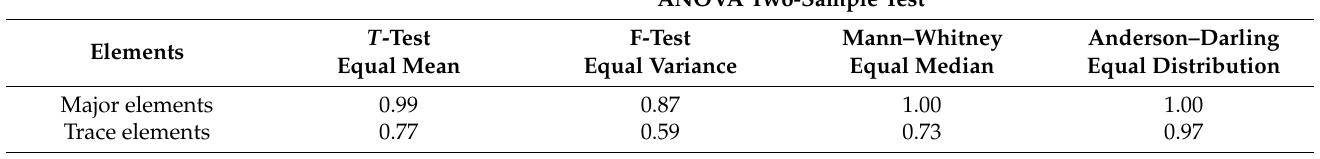
Figure 3. The sediment to soil ratio of mass fractions of investigated elements (red line) as well as the corresponding standard deviation (gray background) ( a ); and a biplot illustrating the reciprocal distribution of investigated elements in sediments and soils excepting the Zn, As, Sb and Hg, i.e., elements whose mass fractions in some places exceeds the UCC [17] ones by two to three orders of magnitude ( b ) (Table 1) [36]. Spearman’s correlation coefficient of 0.837 at p < 0.01. Table 2. The results of two-sample ANOVA tests illustrating the probability the major and trace elements being closer in soils and sediments. The results are based on the average mass fractions values reproduced in Table 1. ANOVA Two-Sample Test